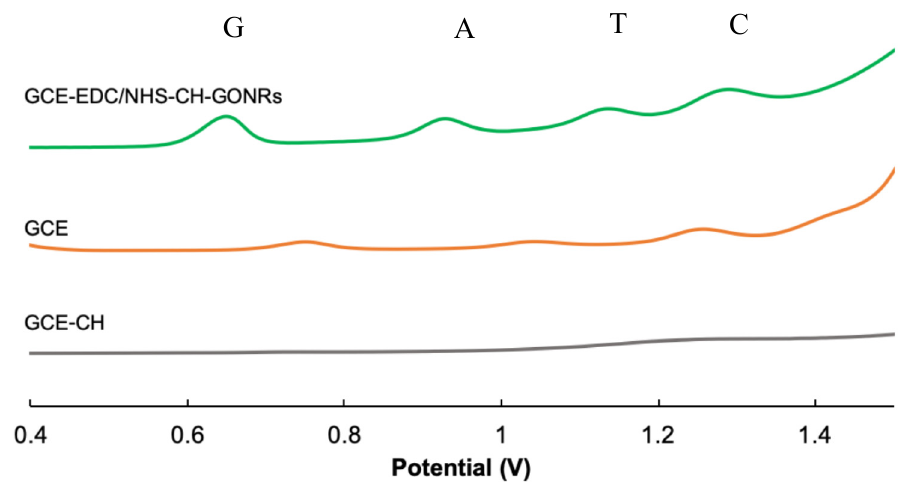
Figure 5. Different pulse voltammetry (DPV) of the GCEs after various modification steps in the presence of G, A, T and C at GCE-CH (grey line), GCE (orange line) and GCE/GONRs-CH (green line) in 0.1 M PBS (pH 7.0) containing 0.001 M of nucleobase solutions.